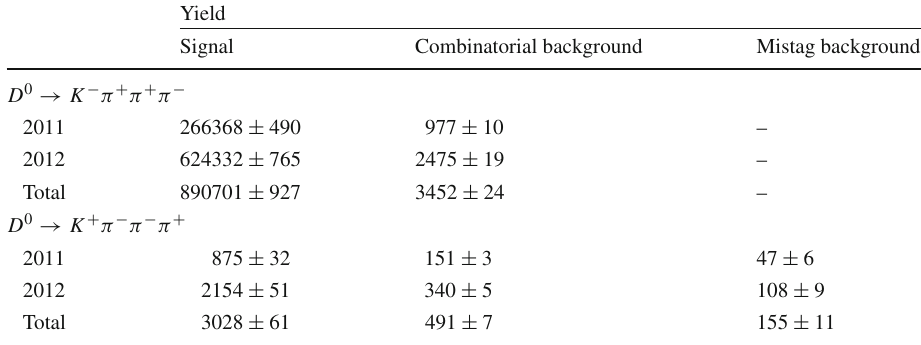
Yield Signal Combinatorial background Mistag